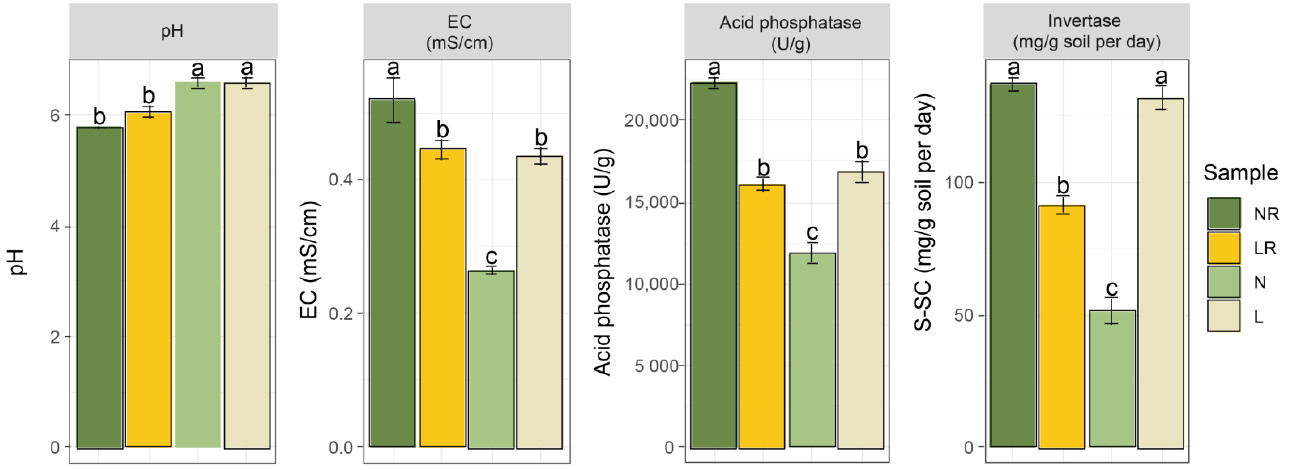
Figure 1. Chemical properties of soils supporting normal or limited growth of highbush blueberry plants. S-SC-soil saccharase (invertase); NR-rhizosphere soil of normally growing plants; LR-rhizosphere soil of plants with limited growth; N-bulk soil of normally growing plants; L-bulk soil of plants with limited growth. Different lower-case letters indicate significant differences ( p ≤ 0.05).